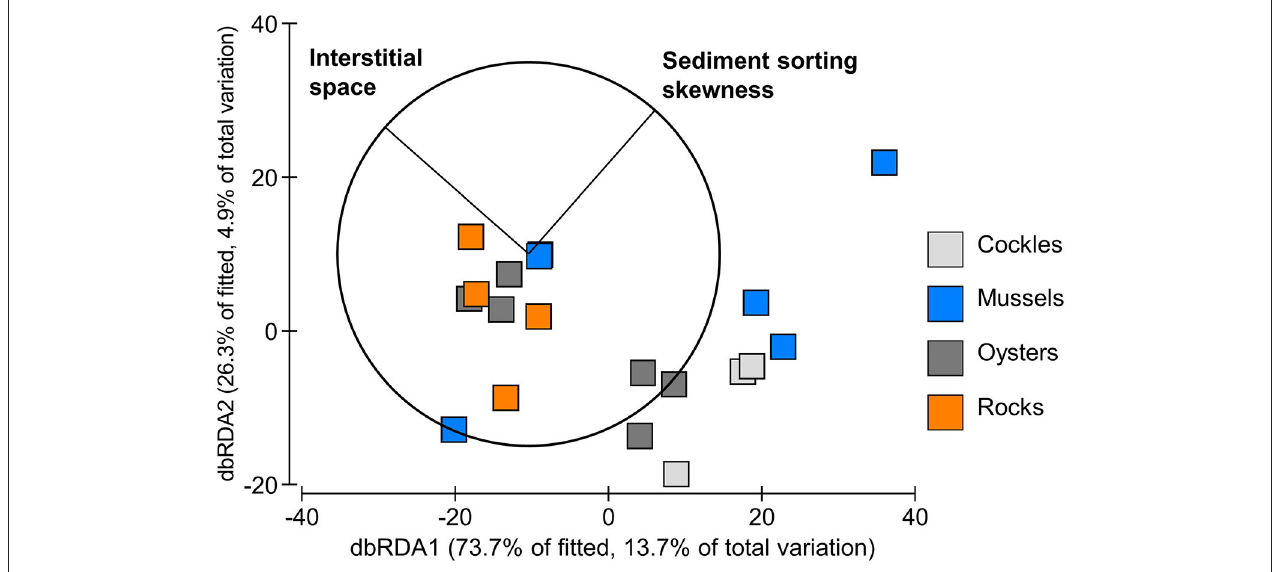
FIGURE 6 | dbRDA ordination of the fitted DistLM model for benthic fauna in experimental reef units filled with shell and rock material (based on Bray Curtis similarities after square-root transformed abundances). Reef characteristics best explaining the variation in the community data are